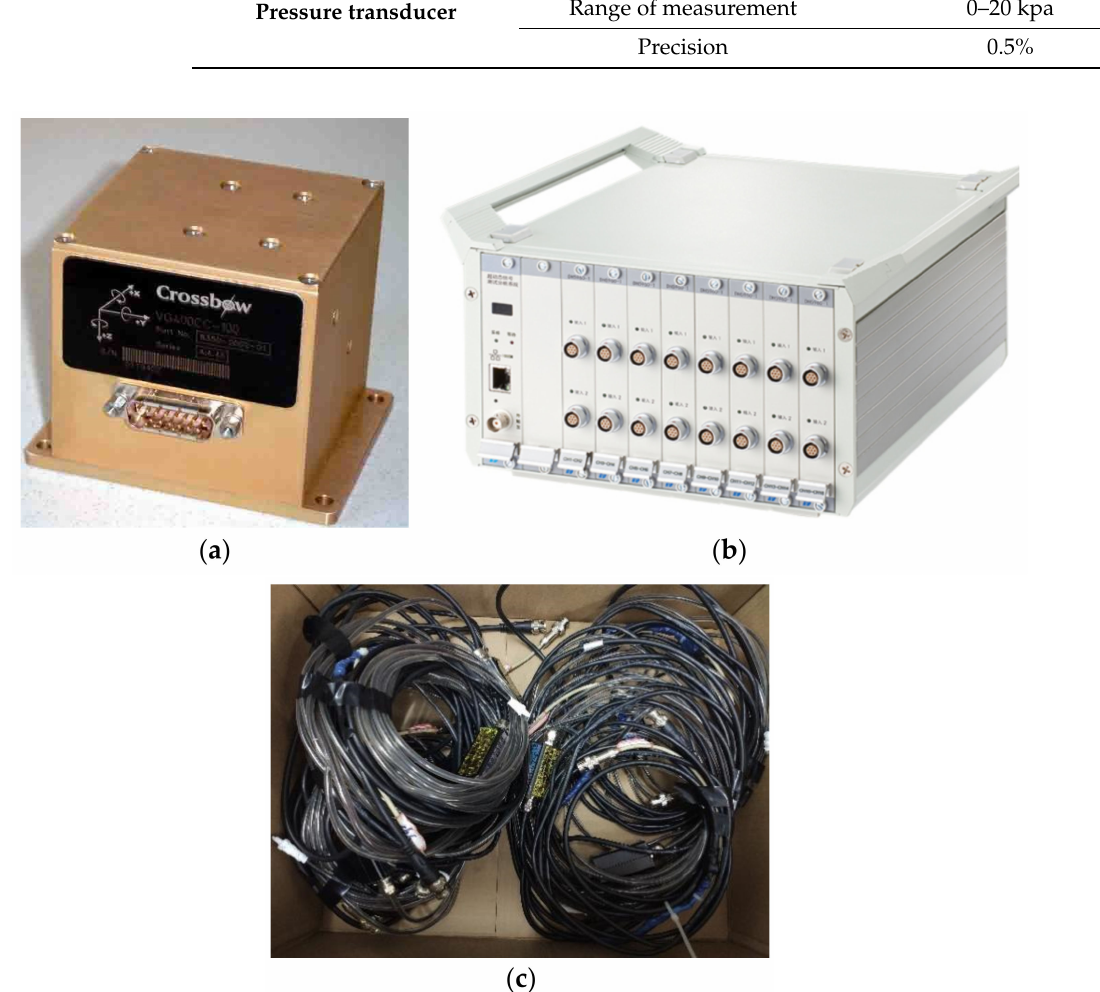
Figure 4. Measuring equipment in the experiment ( a ) The Angle measuring instrument; ( b ) The data acquisition instrument; ( c ) The pressure